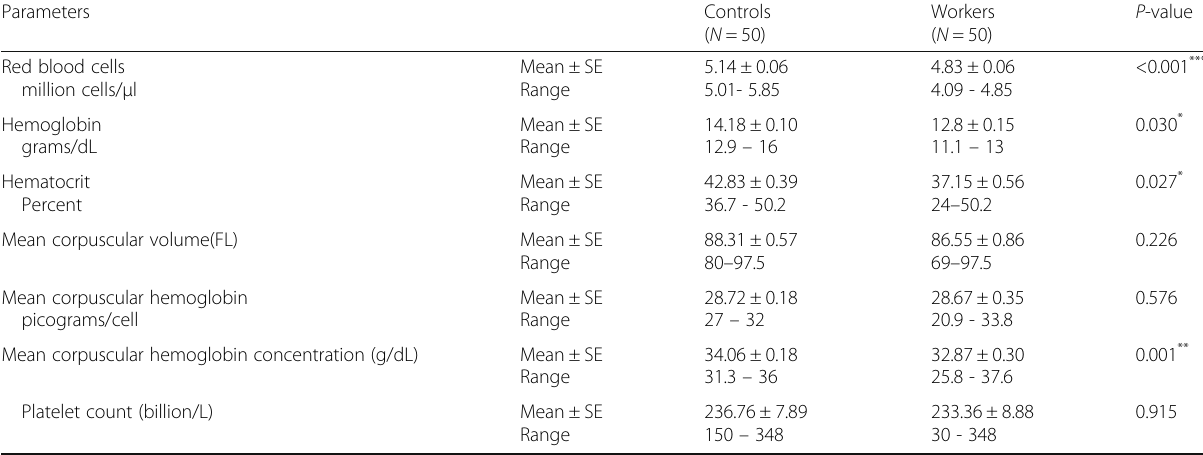
Table 3 Hematological indices in exposed workers compared with healthy controls Parameters Controls